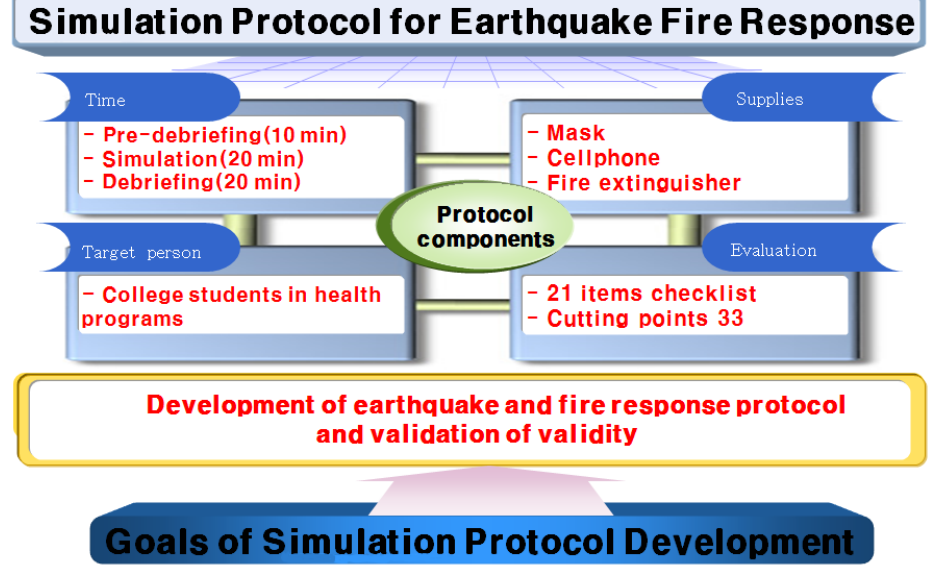
Figure 1. Development of simulation protocol for earthquake fire response.